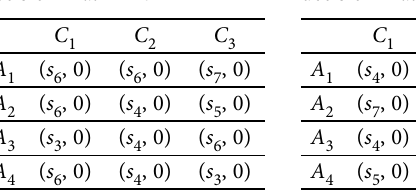
Table 6. 2-tuple linguistic decision matrix 3 R